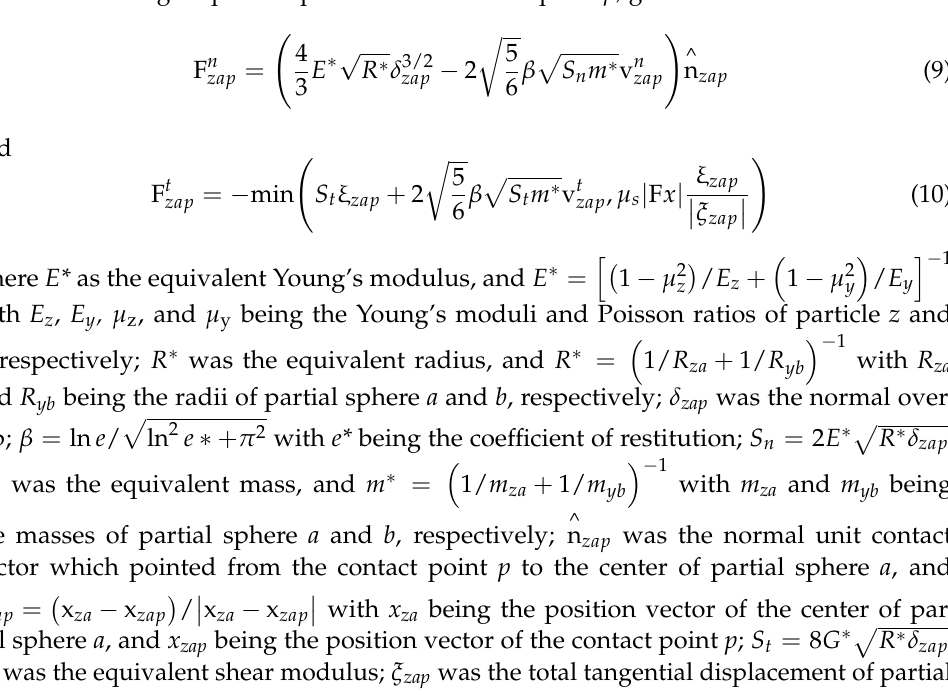
Figure 14. ( a – i ) Multisphere models for different varieties of Cyperus esculentus seeds.